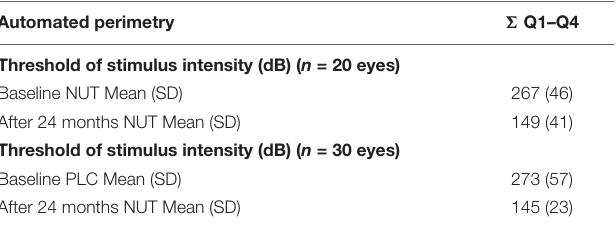
TABLE 5 | Automated perimetry to assess retinal sensitivity at baseline and 24 months after nutritional supplementation. Automated perimetry (cid:54) Q1–Q4